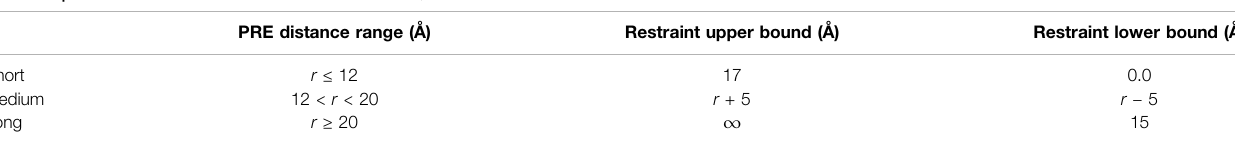
TABLE 1 | Distance bounds for calculated PRE distances, r